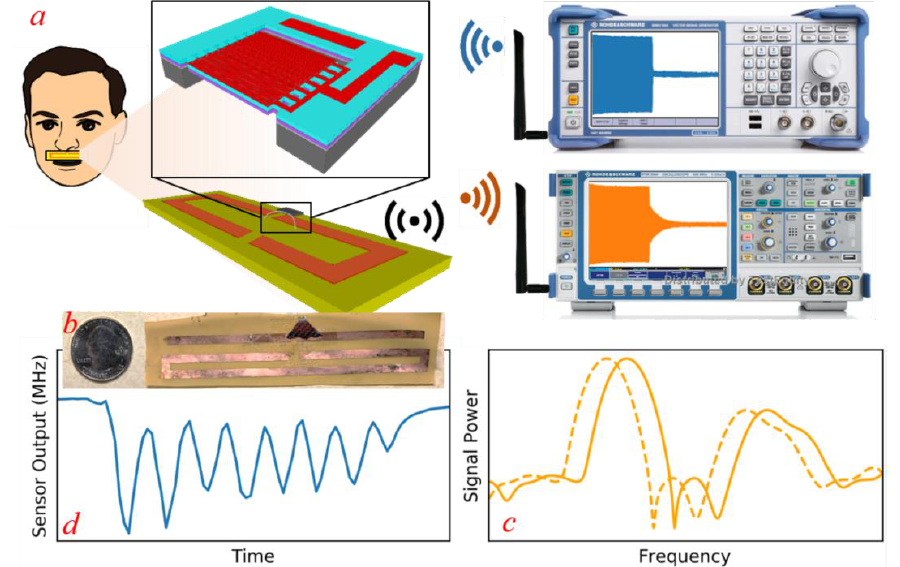
Figure 1. ( a ) A schematic representation of the sensing system. The resonant sensor is excited by a pulsed sinusoidal signal (blue) from a transmitter and its response (orange) as seen by a receiver is analyzed via Fast Fourier Transform (FFT). ( b ) Sample of a sensor used in this study. ( c ) The downward frequency shift of resonators from exposure to respiratory flow. ( d ) Respiratory profile of the healthy subject. Each fall and rise in frequency corresponds to a single respiratory cycle.